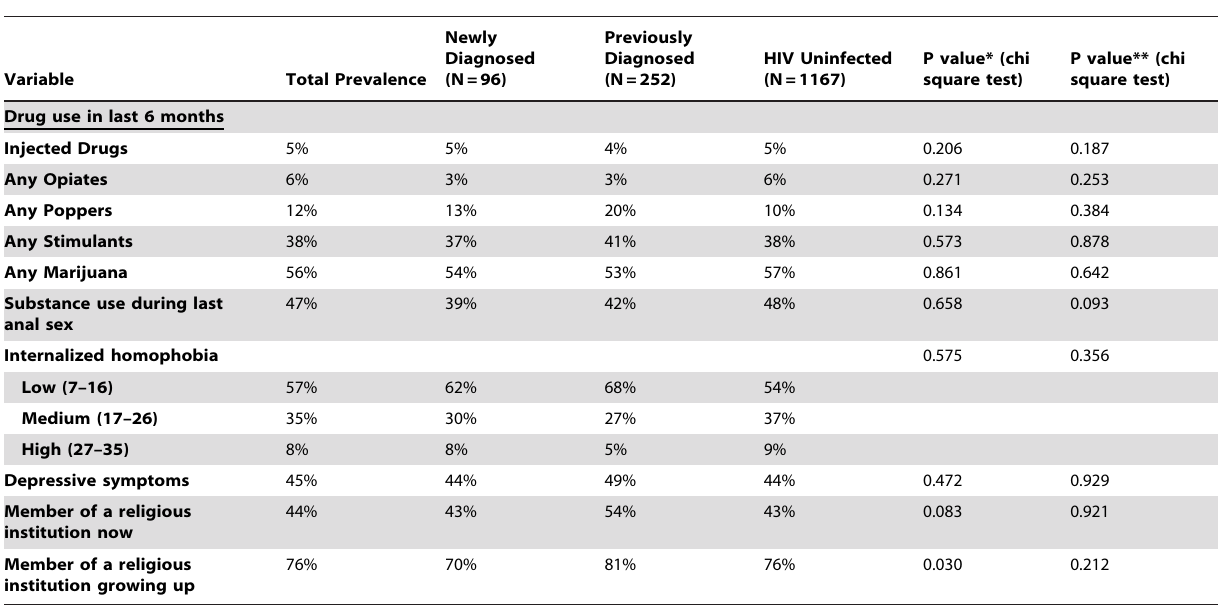
Table 4. Social and behavioral issues among Black men who have sex with men (participants in HPTN 061) by HIV status: Newly diagnosed versus previously diagnosed or HIV-uninfected at baseline (N